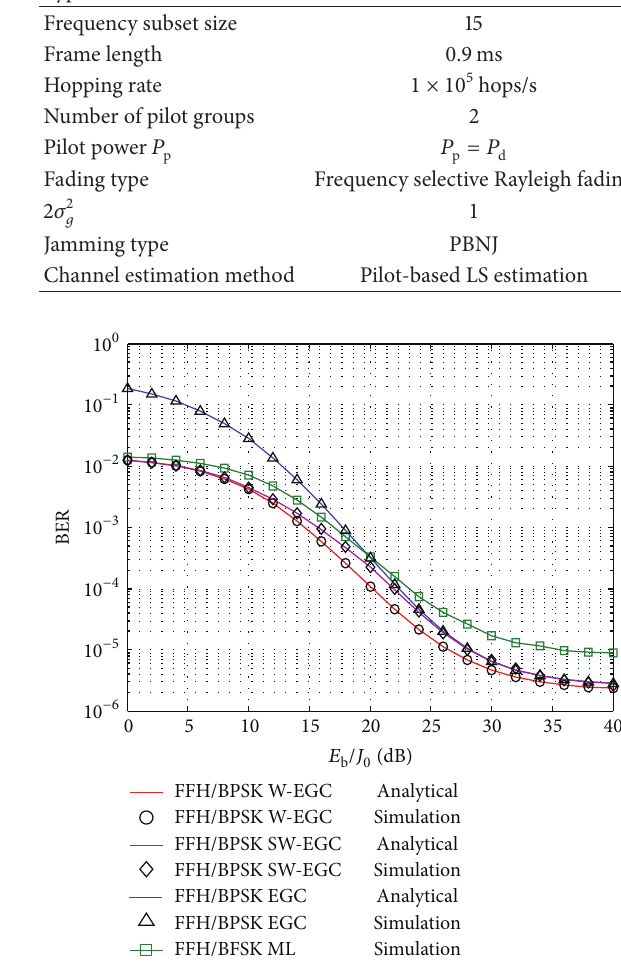
/𝑁 = 25 dB, 𝐿 = 3 , and 𝜌 0 b